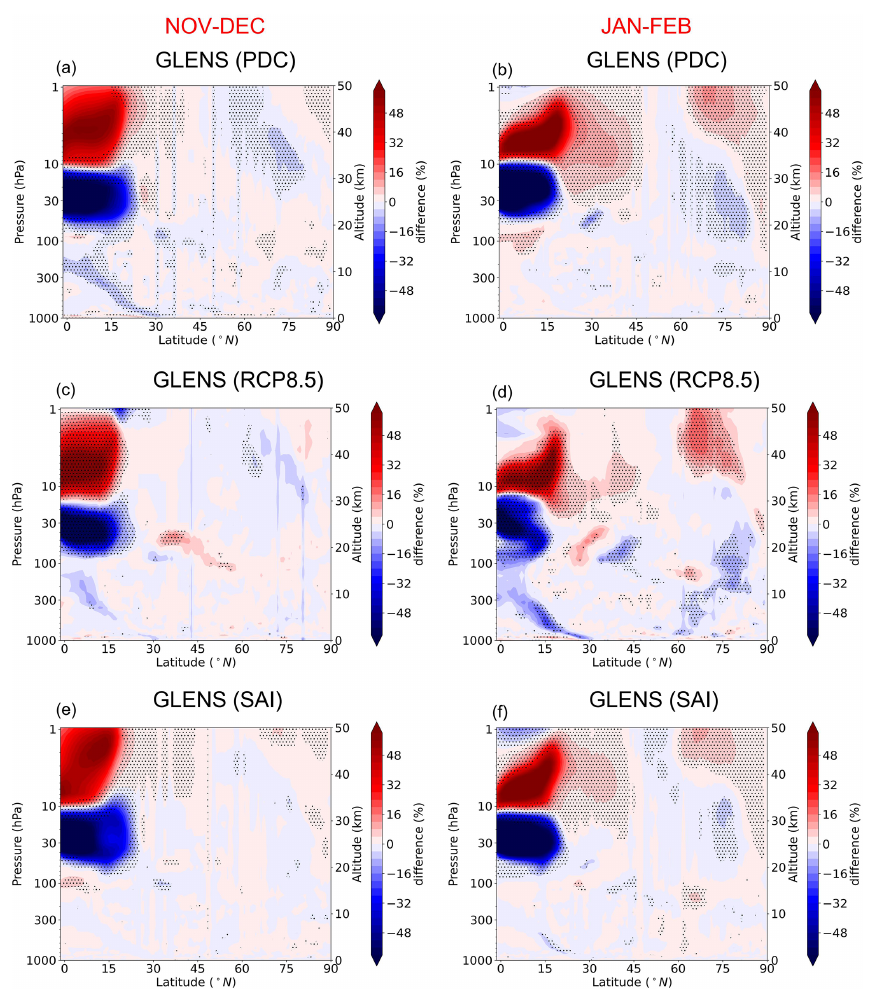
Figure 8. Latitude–pressure cross section of the QBOe–QBOw composite differences in percentages of the favorable propagation condition for the resolved large-scale waves (based on the refractive index of Rossby waves). The stippled areas indicate regions where the changes in the quantity are statistically significant at the 95% level according to the t